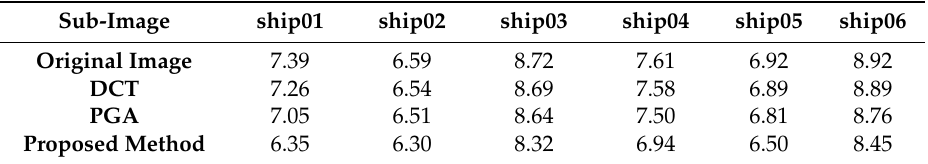
Table 2. The entropies of six